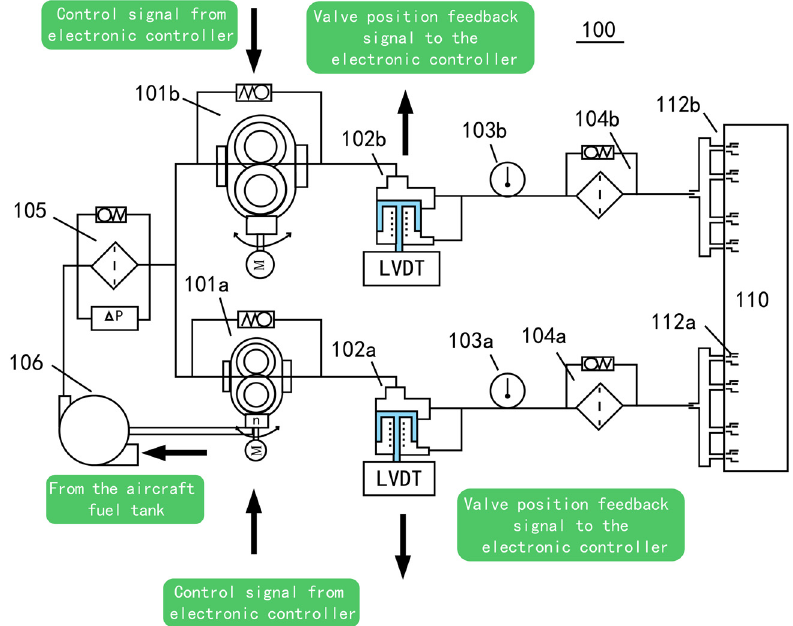
Figure 1: Fuel supply device of aeroengine fuel